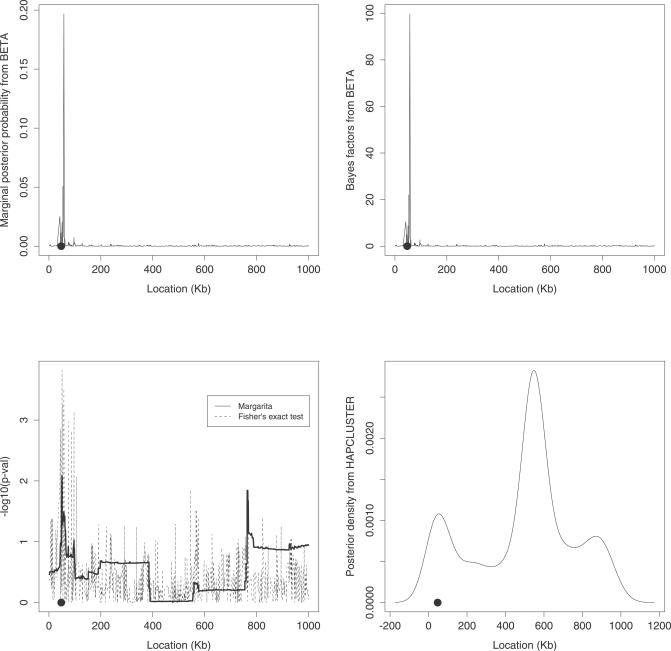
Results from BETA, Margarita, HAPCLUSTER and Fisher's Exact Test from a Single Dataset with One Susceptibility Allele under the Default ScenarioMarginal posterior probability of association from BETA (top left), Bayes factor in favour of association at each marker from BETA (top right), p-values from Margarita and Fisher's exact test (bottom left), and posterior density of location from HAPCLUSTER (bottom right), where the dot on the x-axis indicates the position of the susceptibility mutation.